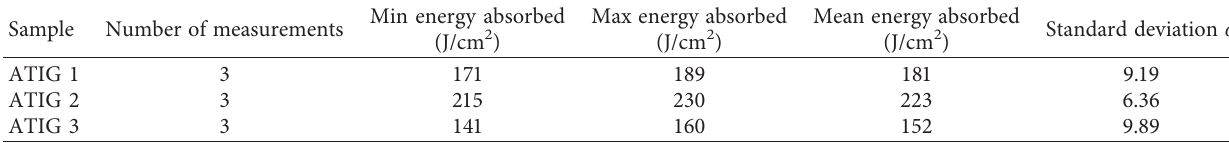
Table 14: Absorbed energy in FZ for ATIG